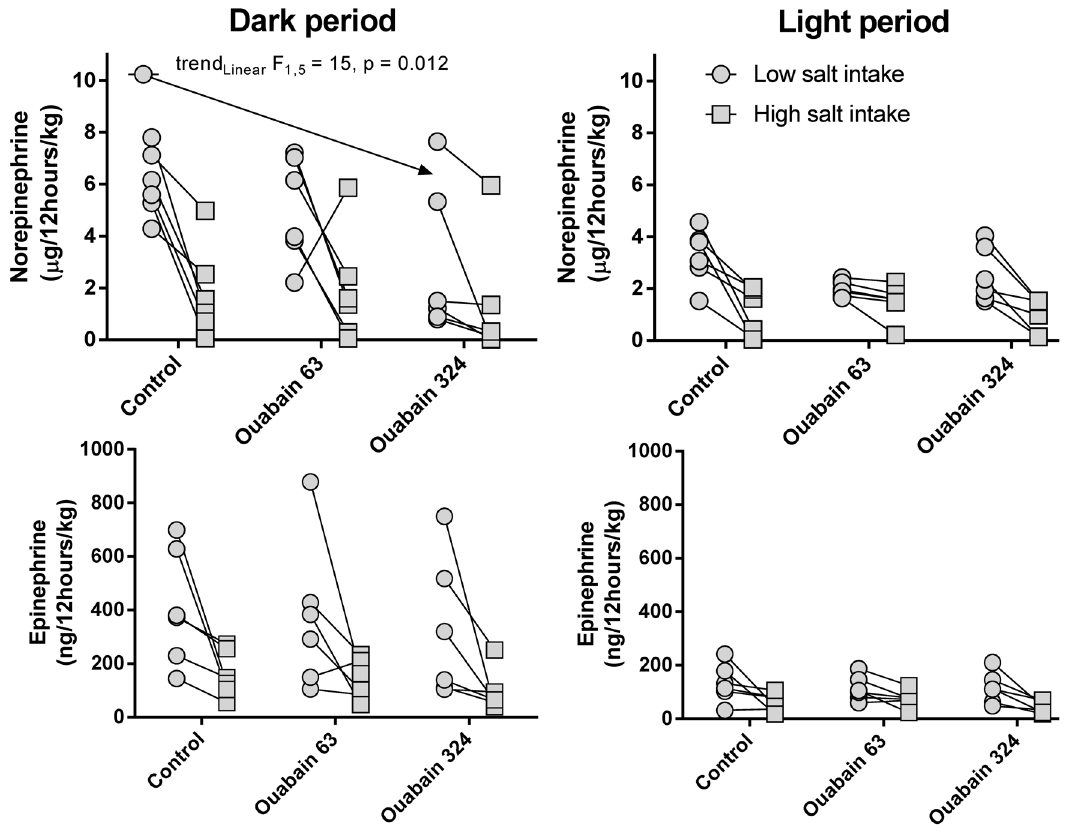
Figure 7. Urine excretion of catecholamines during the periods of low and high salt intake. Control, salt sensitivity test performed before the implantation of the ouabain pellets; Ouabain 63, salt sensitivity test applied to rats treated for 27–29 days with 63 m g ouabain/kg/day; Ouabain 324, test applied to rats treated for 40 days with 63 m g ouabain/kg/day and then for 27–29 days with 324 m g ouabain/kg/day. Data were analyzed with repeated measures MANOVA and the multivariate Wilk’s test in a 3 (ouabain treatment) x 2 (salt intake) x 2 (illumination) design; n=6 rats. The planned trend and contrast analysis was applied if the Wilk’s test was significant (P , 0.05). Norepinephrine: main effect ‘‘ouabain treatment,’’ F 2,4 =7.78, P=0.042; main effect ‘‘salt intake,’’ F 1,5 =27.8, P=0.003; main effect ‘‘illumination,’’ F 1,5 =7.29, P=0.043; no interactions were significant. The arrow indicates a significant linear declining trend for norepinephrine urine excretion during the low salt intake of the dark period. Epinephrine: main effect ‘‘ouabain treatment,’’ F 2,4 =1.31, P=0.36; main effect ‘‘salt intake,’’ F 1,5 =6.89, P=0.047; main effect ‘‘illumination,’’ F 1,5 =16.1, P=0.01; no interactions were significant.